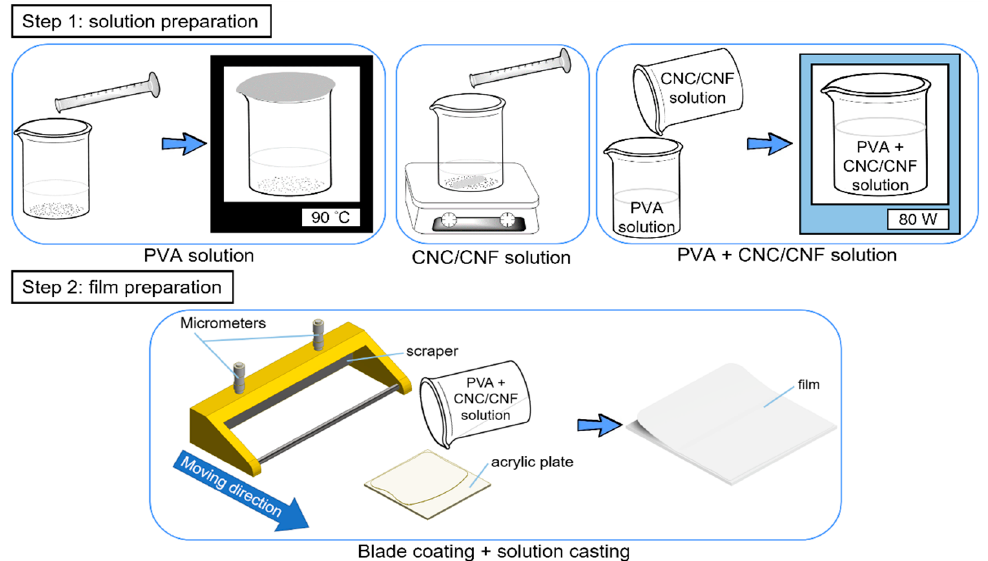
Figure 1. Preparation of PVA + CNC/CNF nanocomposite films.